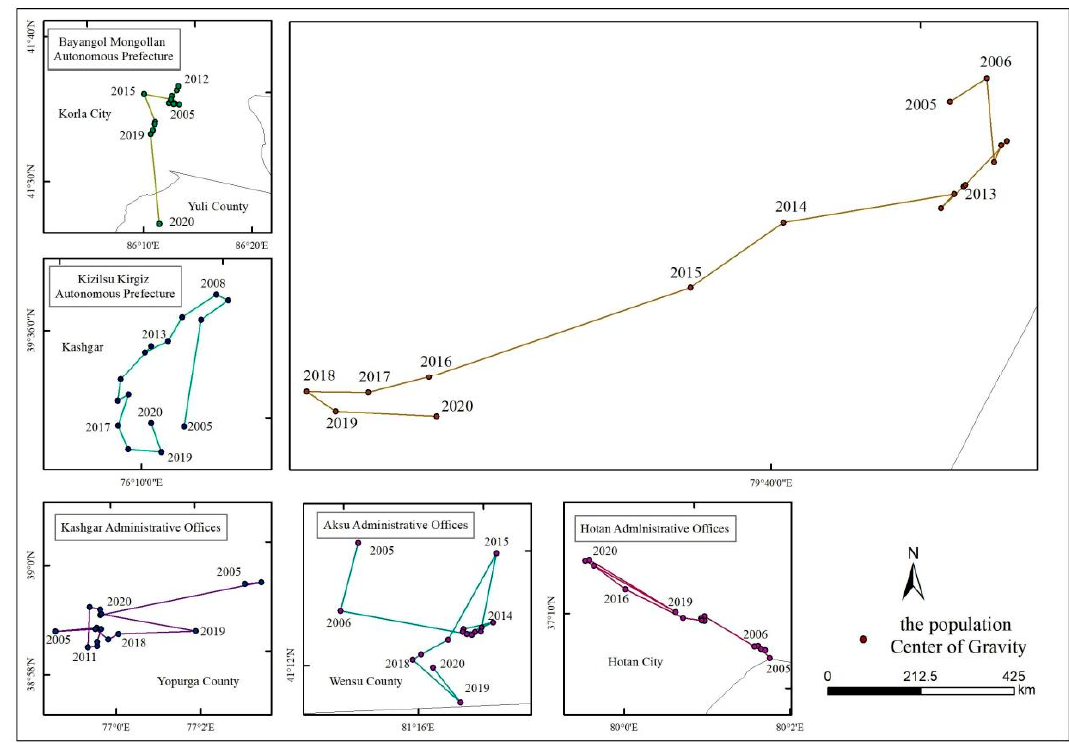
Figure 7. Evolutionary track of the population CG in the Tarim River Basin.